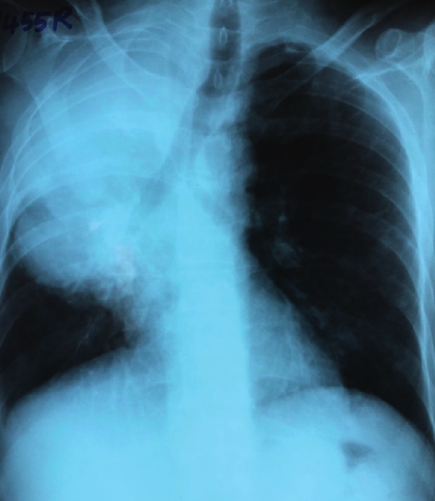
Figure 2: Chest radiograph—posterior-anterior view—right side apical ill-defined mass causing tracheal deviation to opposite side.